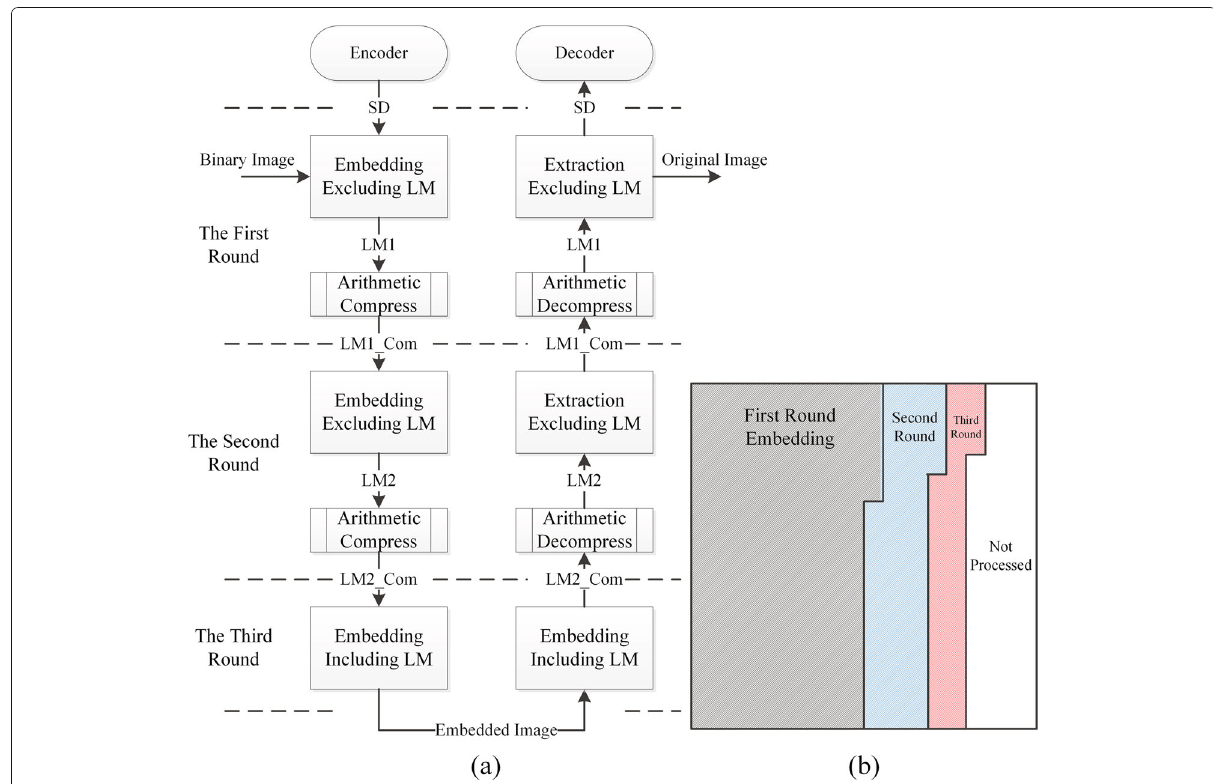
Fig. 10 The three-round embedding mechanism: a the flowchart; b the three-round embedding on the binary image